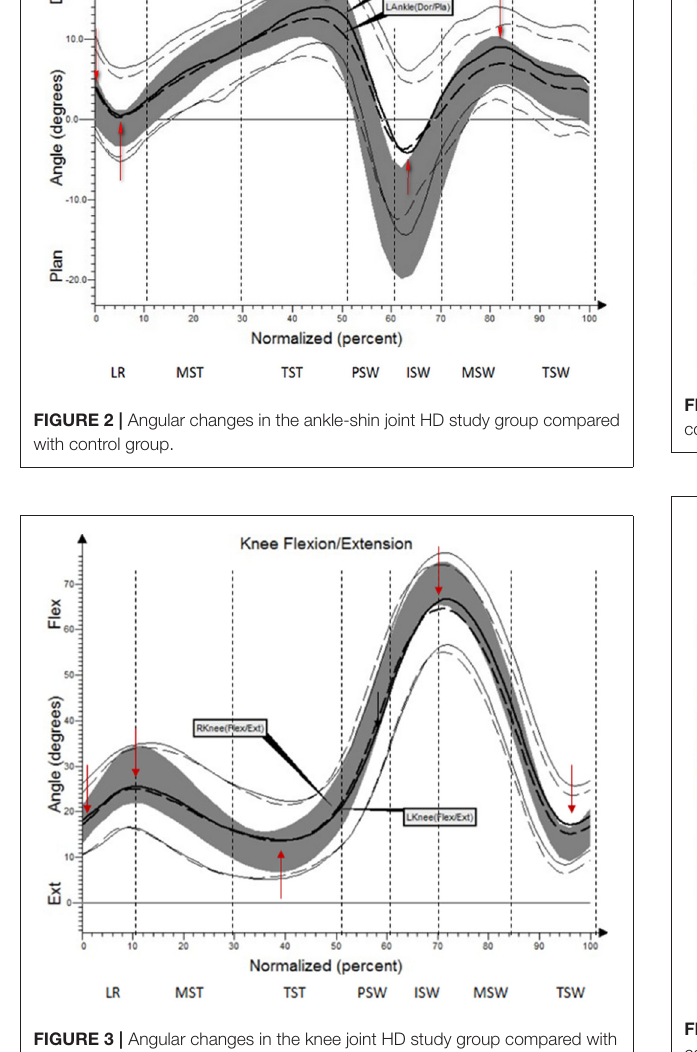
FIGURE 3 | Angular changes in the knee joint HD study group compared with control group.